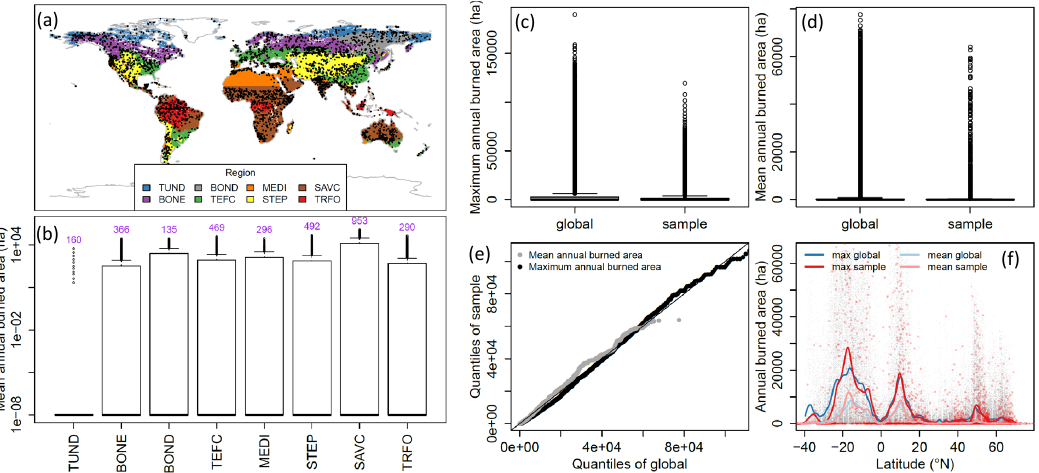
Figure A2. Representativeness of sampled 0.25 ◦ grid cells for global patterns of burned area (based on GFED burned data). (a) Spatial distribution of the grid cells of the optimization and evaluation data subsets and regions for regional analyses of results. Regions are TUND (tundra), BONE (boreal needle-leaved evergreen and mixed forests), BOND (boreal needle-leaved deciduous forests), TEFC (temperate forests and croplands), MEDI (Mediterranean regions), STEP (steppes), SAVC (savannahs and tropical croplands), and TRFO (tropical forests). (b) Distribution of mean annual burned area per region from the sampled grid cells. Numbers indicate the number of grid cells per regions. (c–f) Comparison of mean and maximum annual burned between all global grid cells and the sampled grid cells. (c) and (d) : distri- bution of maximum and mean annual burned. (e) Quantiles of mean and maximum annual burned area. (f) Latitudinal gradients of annual burned area. Latitudinal gradients are smoothing splines fitted to the 0.95 quantile of mean and maximum annual burned area, respectively.